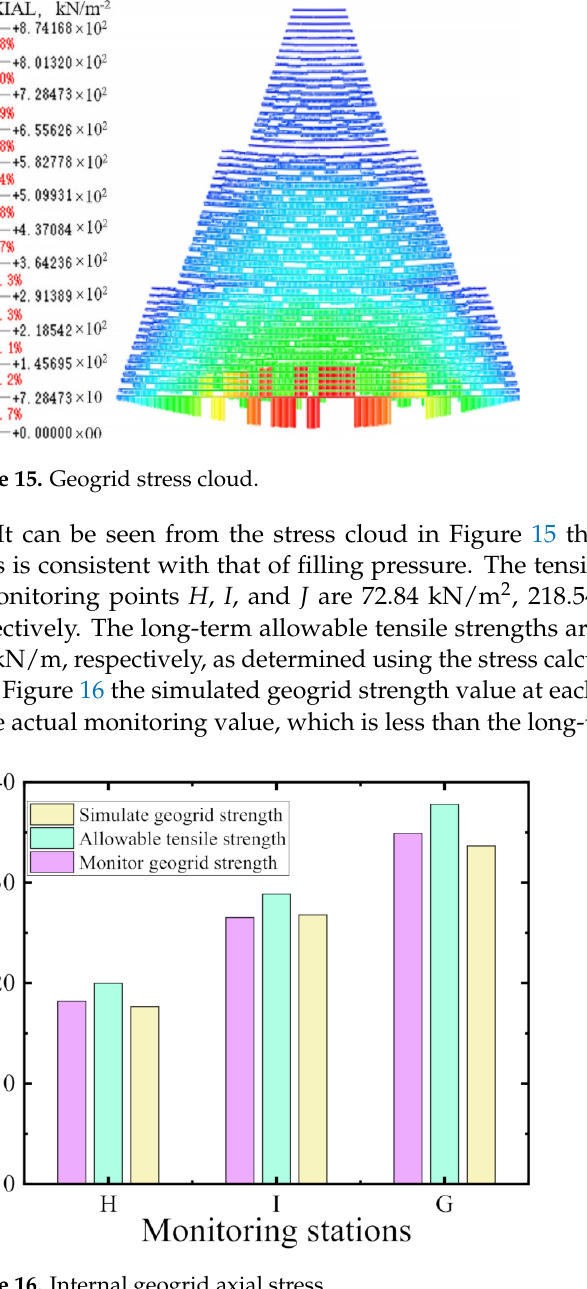
Figure 16. Internal geogrid axial